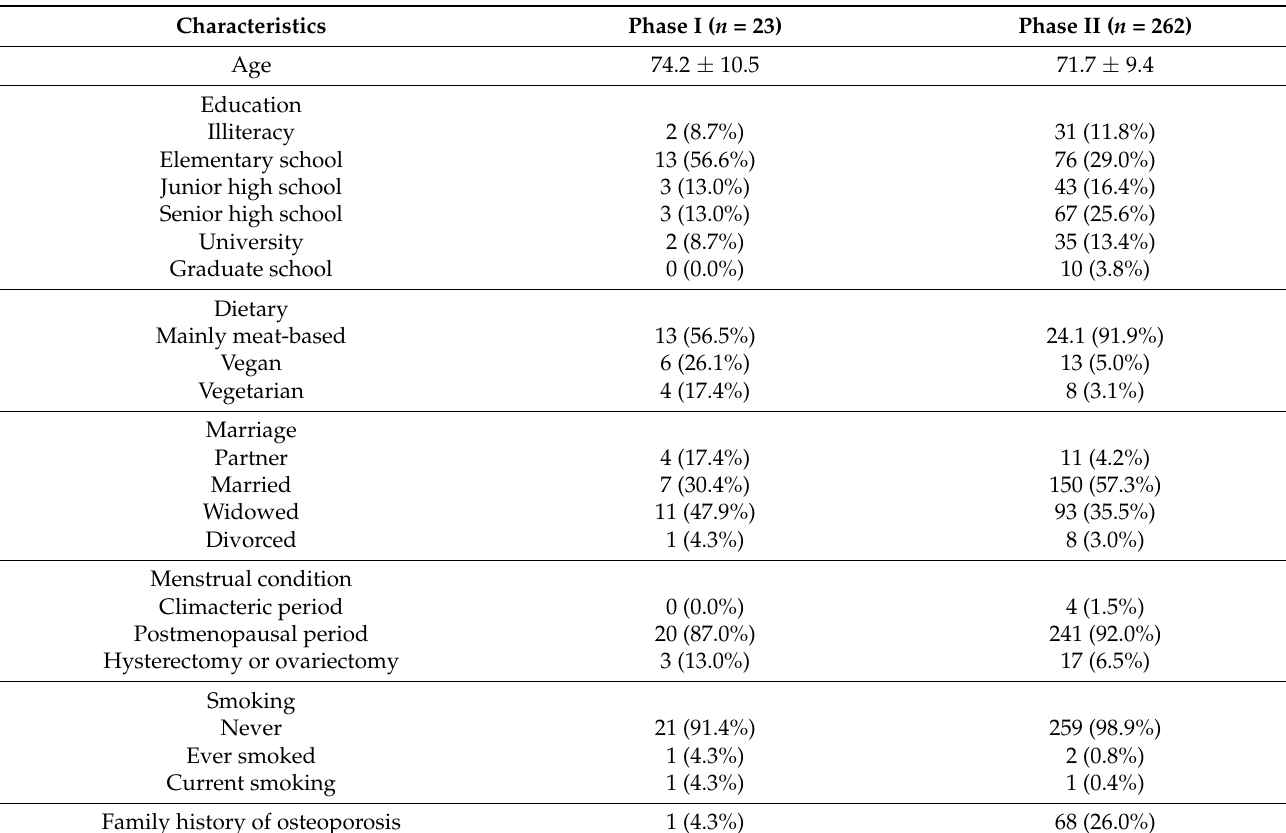
Table 1. Characteristics of participants of phase I and phase